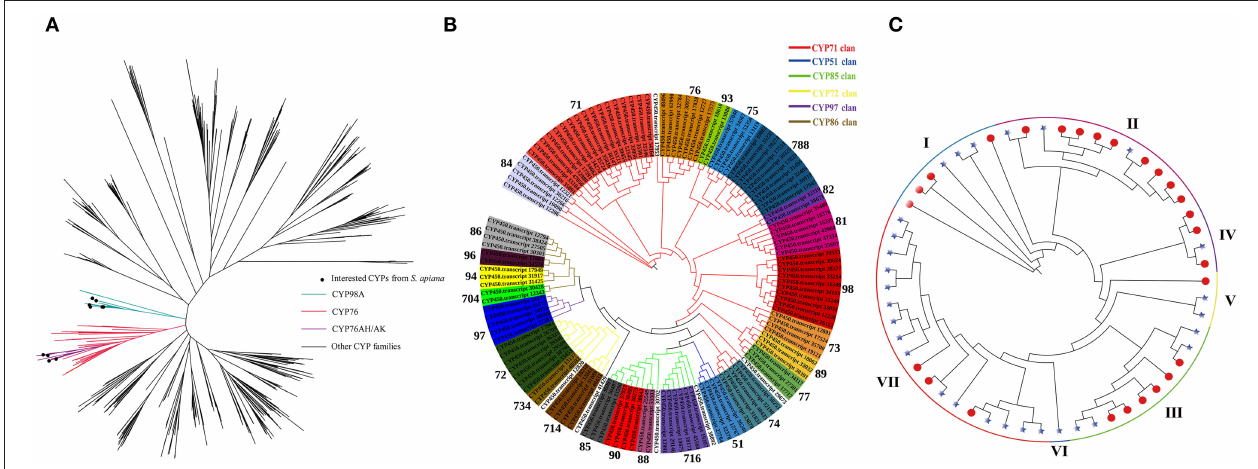
FIGURE 7 | Phylogenetic analysis of cytochrome (CYP) and laccase gene families from S. apiana . (A) Maximum likelihood (ML) phylogenetic tree of 132 CYPs from S. apiana compared to 578 CYPs from other plant species. The blue branch represents the CYP98A subfamily. The red branch represents the CYP76 family, with CYP76AK and CYP76AH subfamilies in purple. (B) Maximum likelihood (ML) phylogenetic tree of 132 CYPs from S. apiana . Branches in different colors represent different CYP clans: CYP71 (red), CYP51 (blue), CYP85 (green), CYP72 (yellow), CYP97 (purple), and CYP86 (brown). Subfamilies were indicated by background colors. (C) ML phylogenetic tree of laccases from S. apiana (asterisks) and Salvia miltiorrhiza ( S. miltiorrhiza ) (red